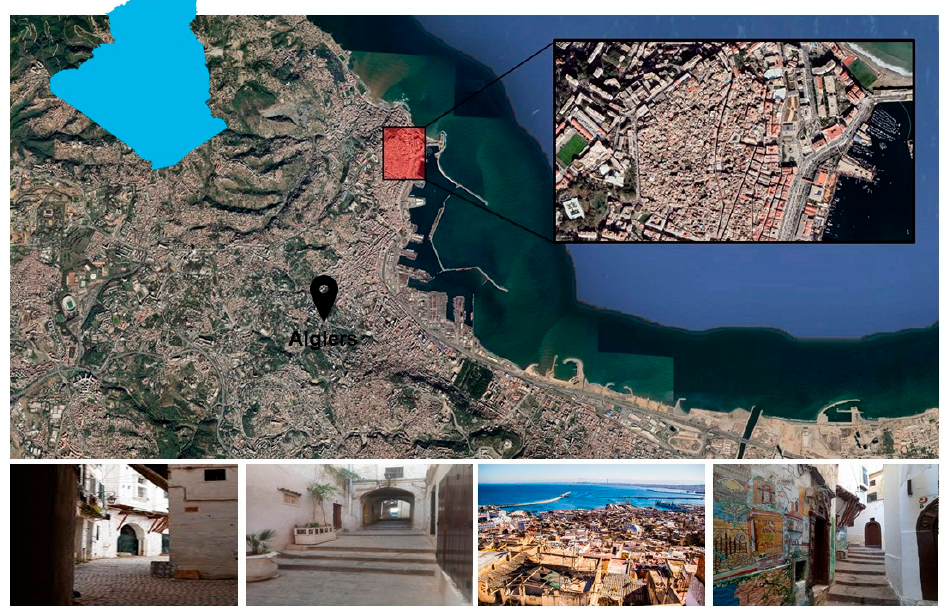
Figure 3. Location of the historic urban fabric studied in the territory of the city of Algiers.